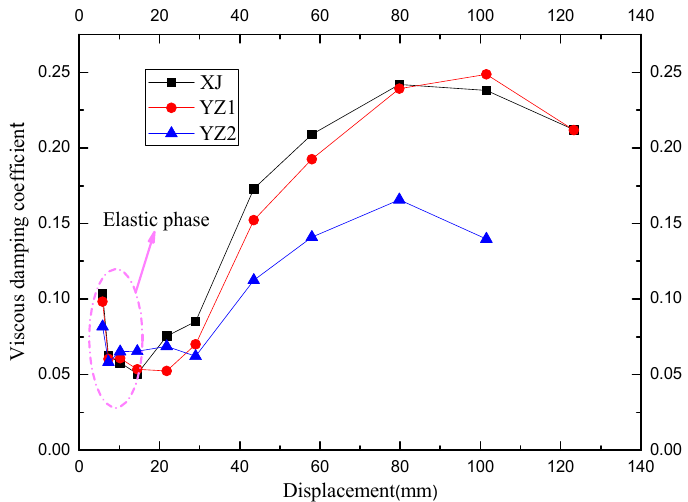
Figure 15. A comparison of the equivalent viscous damping coefficients.